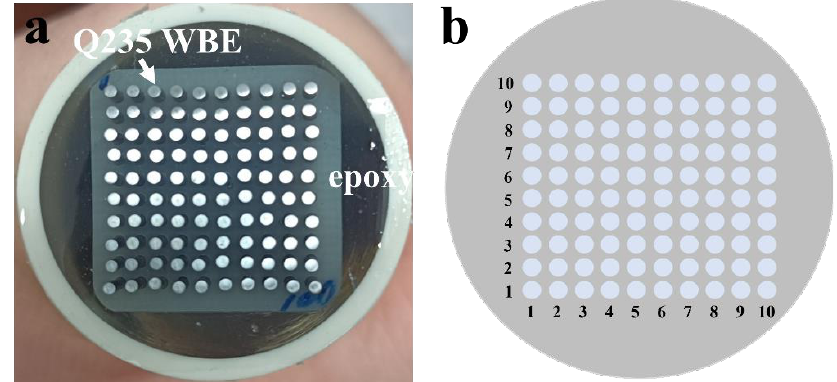
Figure 1. Photo of Q235 carbon steel WBE ( a ) and distribution of the WBE array ( b ).